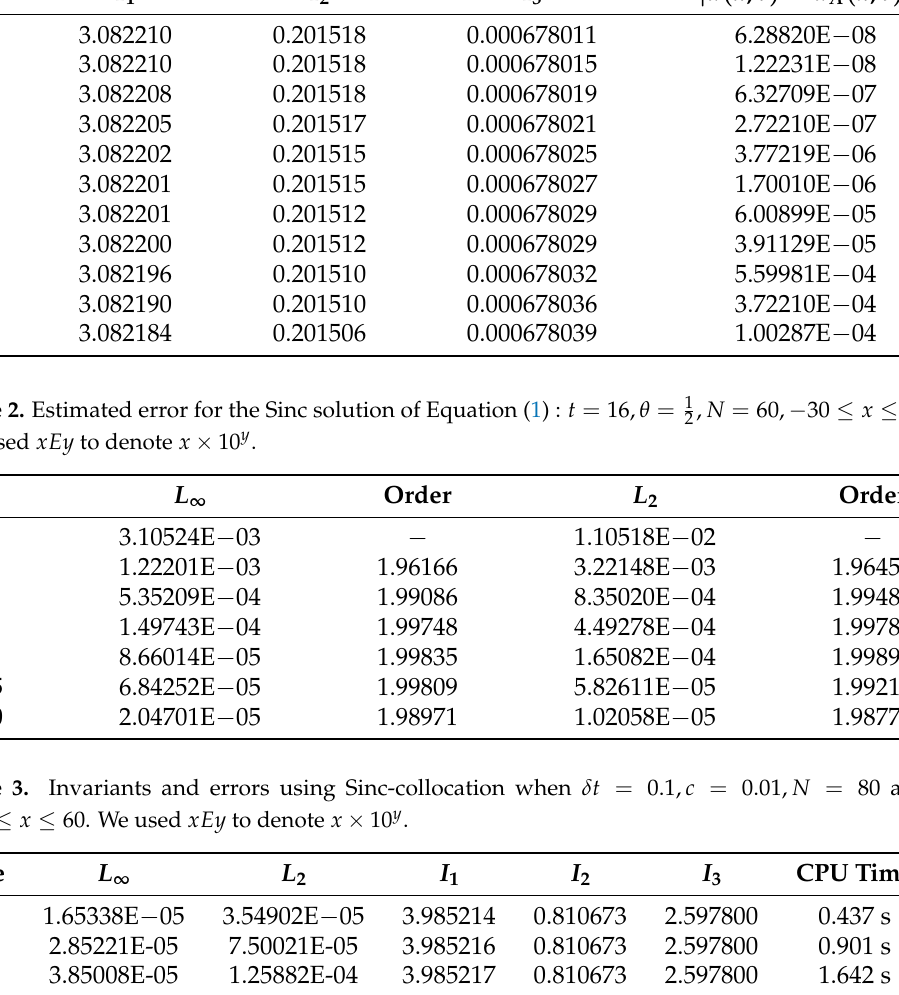
Table 1. Invariants for MRLW equation using ADM when c = 0.01 and 0 ≤ x ≤ 60. We used xEy to denote x × 10 y .